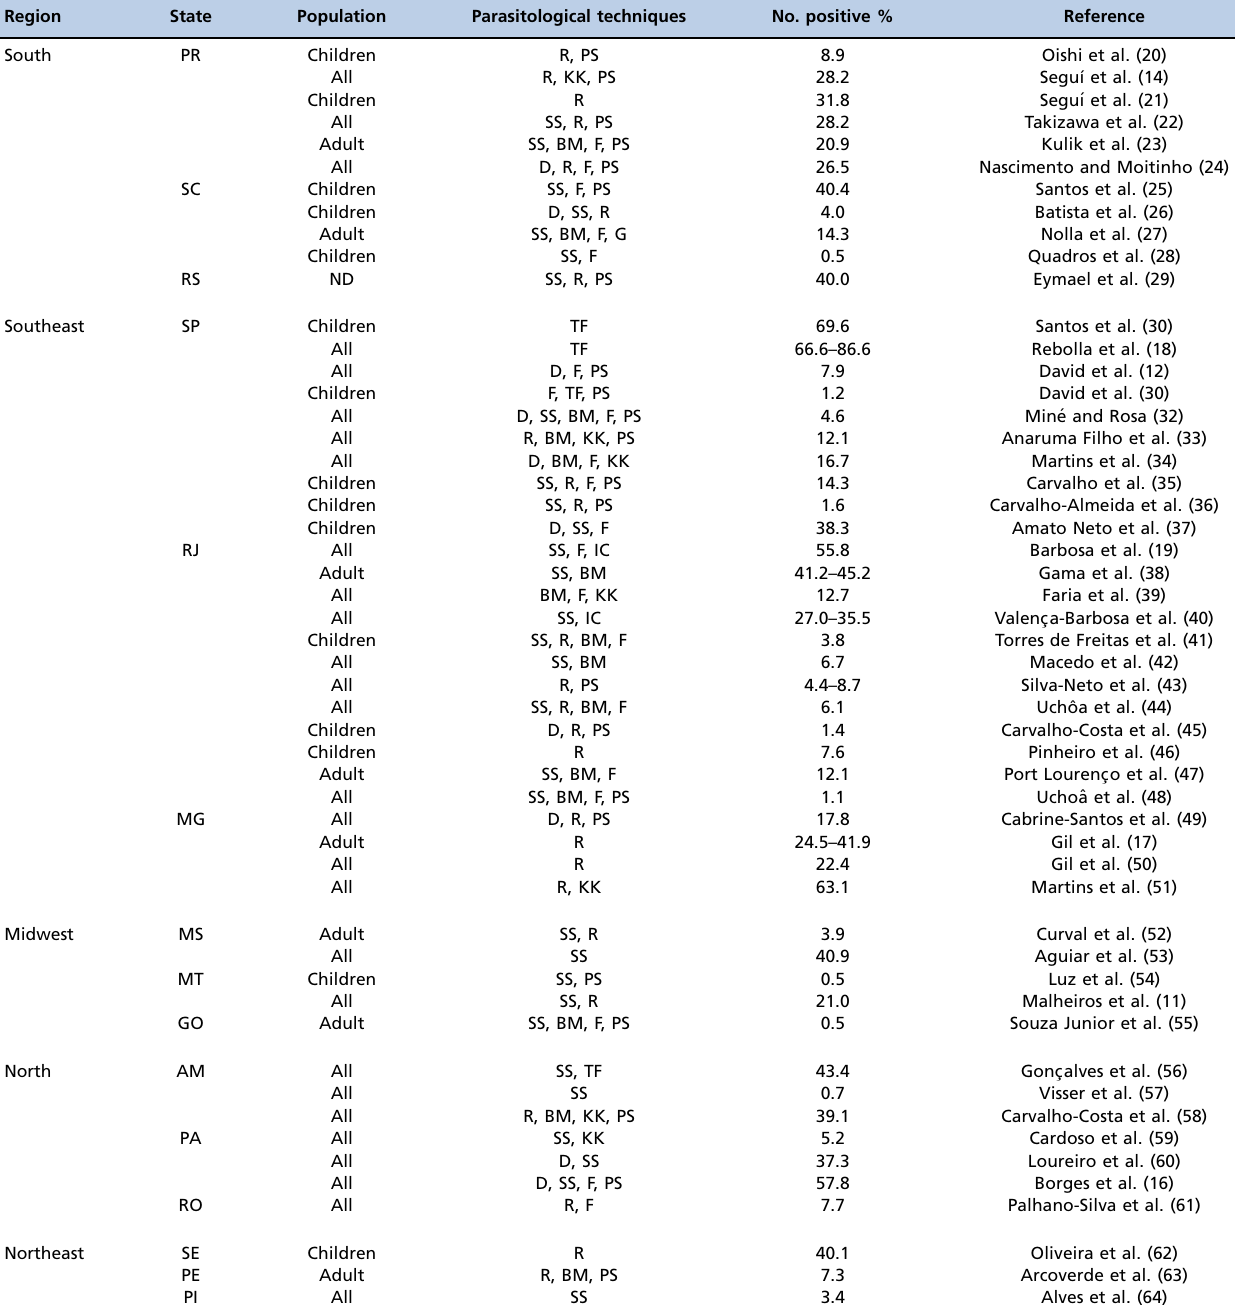
Table 1 - Occurrence of Blastocystis sp. in fecal samples in humans based on the parasitological methods used, the region and state in Brazil, and the population studied (2000–2020). Region